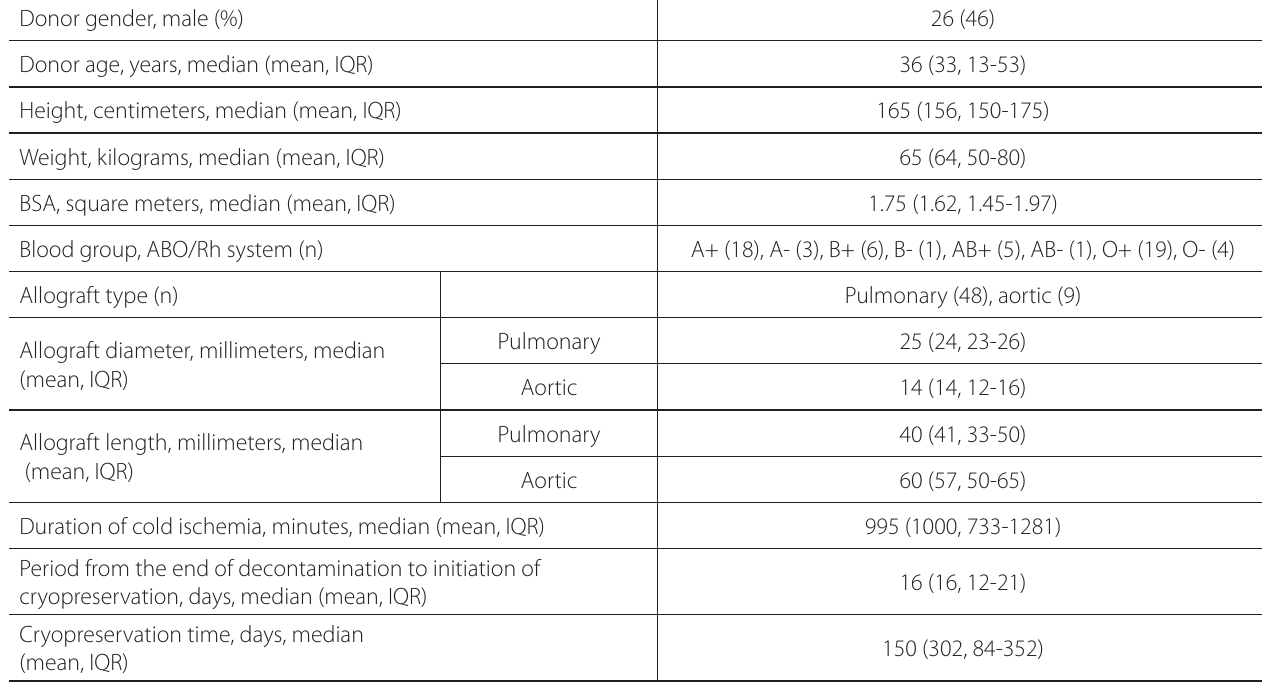
Table 1 . Clinical details of the cadaveric donors and allograft valves’